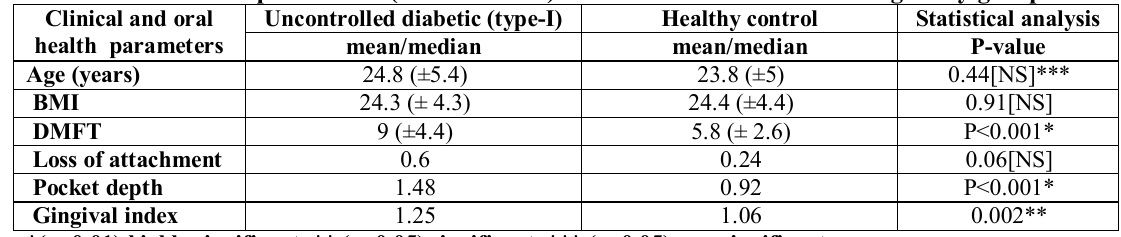
Table 1: Clinical parameters (mean/median) and Standard deviation among study groups Clinical and oral